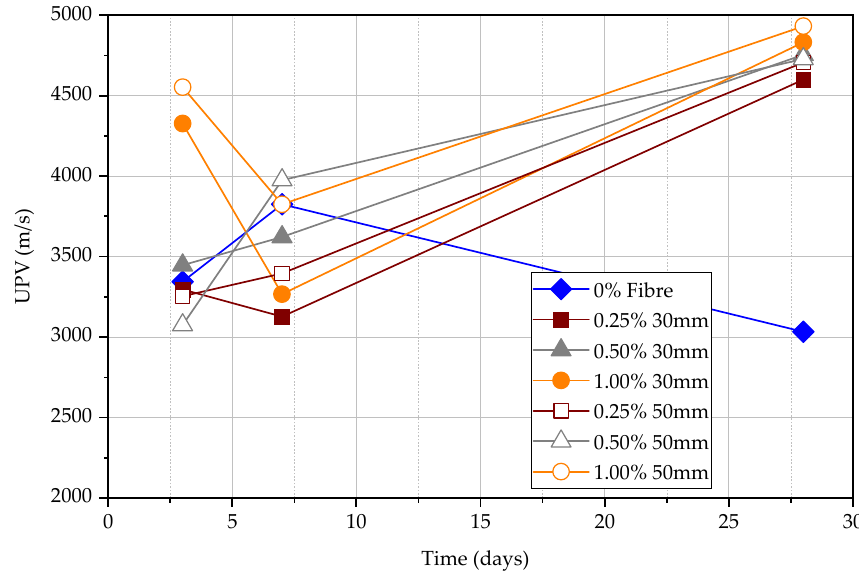
Figure 14. Semi-direct UPV measurements at 3, 7, and 28 days.